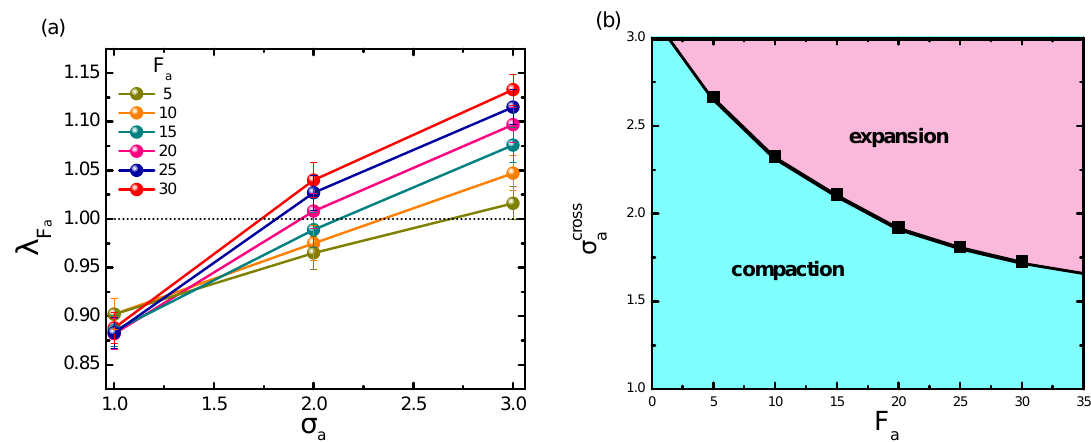
Figure 4. ( a ) Dependence of λ F on crowder size σ a , under varying active forces F a . Error bars a correspond to one standard deviation. ( b ) The predicted phase diagram for the shrinkage-swelling transition, plotted in parameter space ( σ a , F a ). In the calculation, the volume fraction is fixed at φ = 0.1, and the polymer rigidity is given as κ =